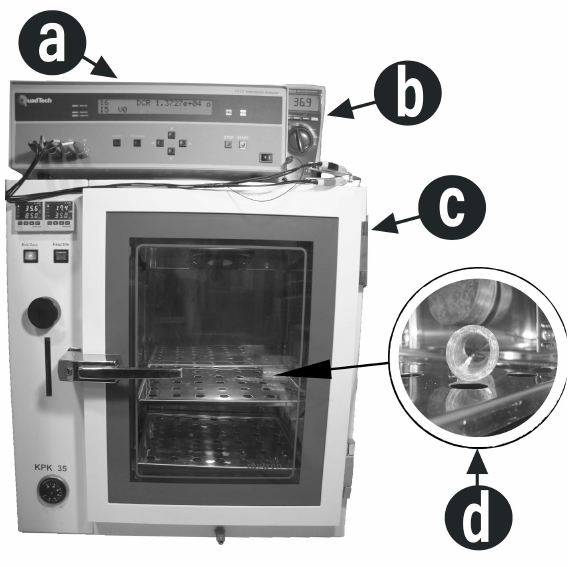
Figure 4. Experimental configuration to obtain the characteristic of the fuel cell thermistor: ( a ) QuadTech 1910 inductance analyzer used to accurately measure the resistance; ( b ) Fluke 179 digital multimeter to verify the measurement of temperature inside the oven; ( c ) Mytron’s KPK 35 oven; ( d ) thermistor under test.